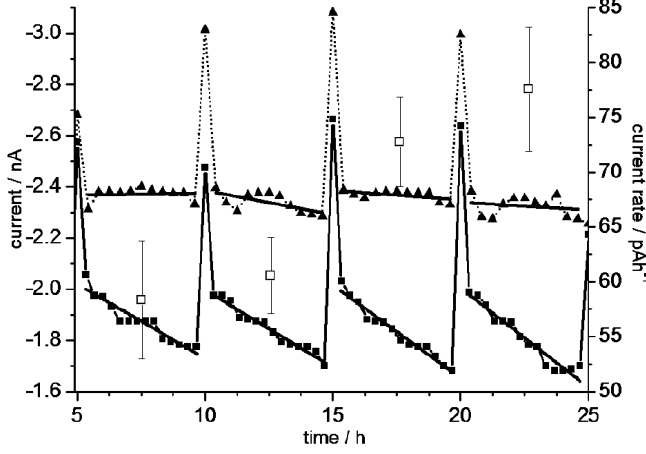
Figure 8. Exemplary oxygen-sensor currents (left ordinate) measured in the microfluidic cell-culture system without cells (dotted lines, triangles) and in the presence of cells (solid lines, squares). The five-hourly current peaks correspond to the pumping cycles of medium exchange during cell culture. The abscissa data without cells was normalized to correspond to the measurements with cells. Measuring points in between the pump cycles were fitted by lines. The continuously increasing slopes in cell culture describe current rates which correspond to increasing oxygen-consumption rates of cells (right ordinate, open squares). The minimum and maximum of all lines with cells are plotted in the insert of Figure 7, marked by